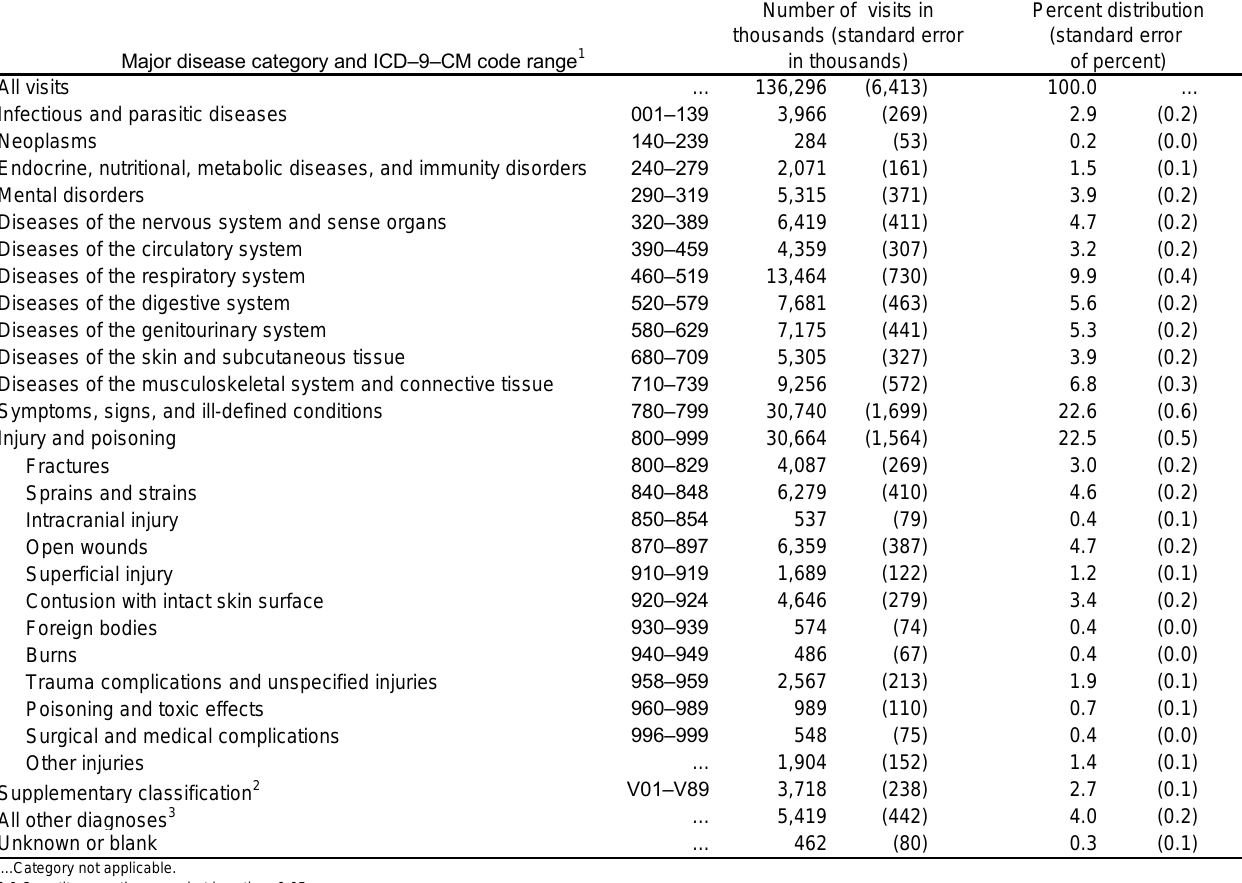
Table 11. Primary diagnosis at emergency department visits, classified by major disease category: United States, 2011 Major disease category and ICD–9–CM code range 1